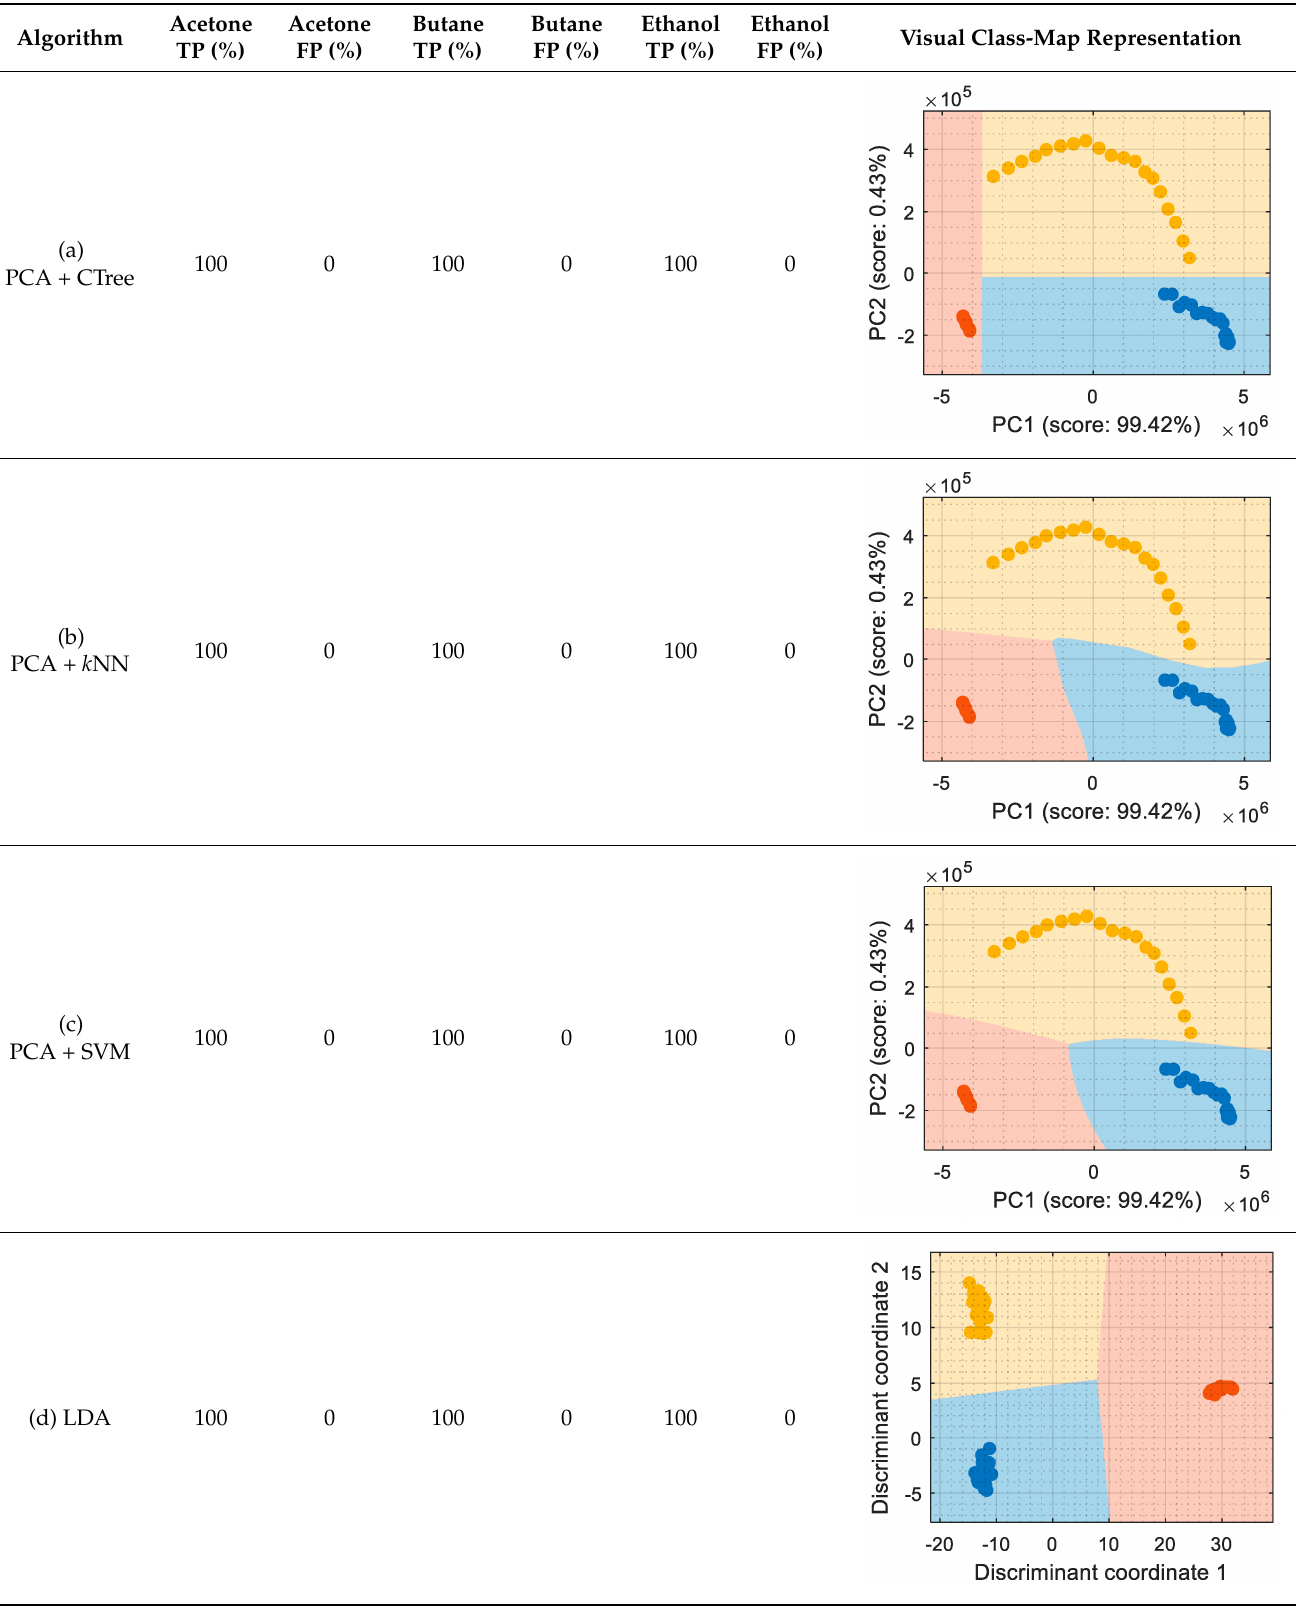
Table 1. Performance of the classifiers when processing the information gathered from the eNose as raw resistance: representations of true positive (TP) and false positive